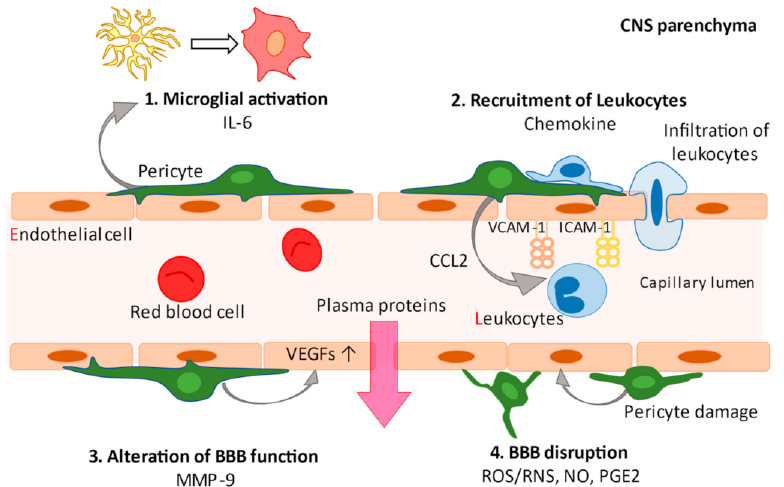
Figure 2. In pathological conditions, pericytes generate various inflammatory factors. Pericytes secrete IL-6 that can polarize parenchymal microglia to a proinflammatory phenotype to activate microglia (1). The secretion of chemokines (CCL2, CXCL1, CXCL8, and CXCL10) by pericytes recruits leukocytes to the CNS parenchyma via the upregulation of ICAM-1 and VCAM-1 adhesion molecules on the endothelium (2). MMP-9 secretion stimulates the production and secretion of vascular endothelial growth factor (VEGF), resulting in endothelial dysfunction (3). Secretion of reactive oxygen species/reactive nitrogen species (ROS/RNS), nitric oxide (NO), and prostaglandins (PGE2) by pericytes lead to vasodilation and breaching of the blood–brain barrier. Pericytes themselves are morphologically altered by inflammatory mediators